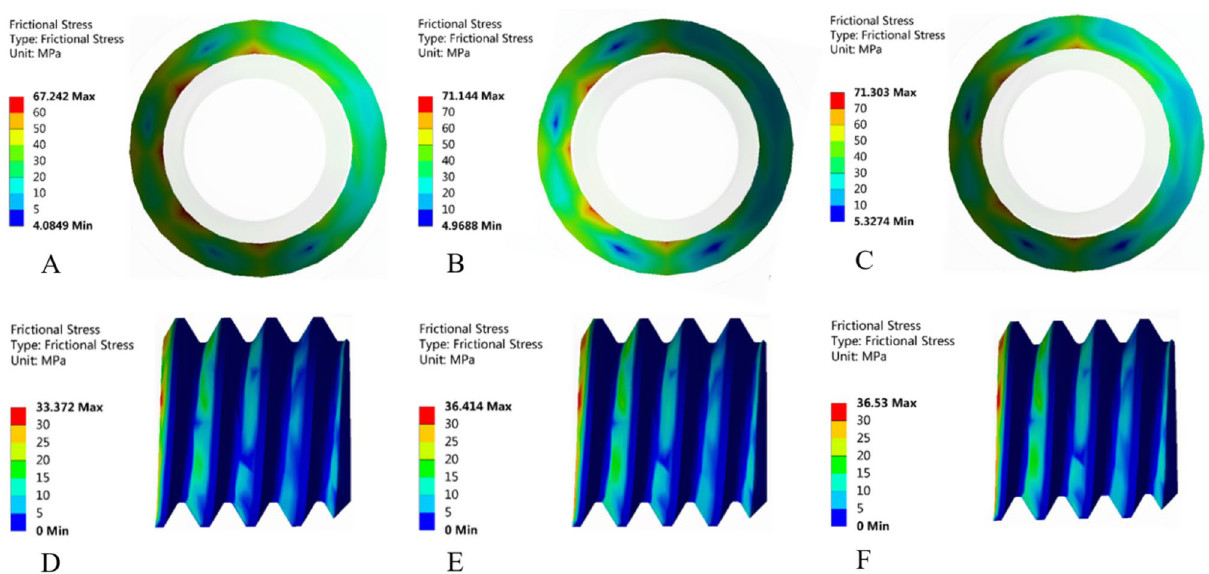
Figure 10. Frictional stress distribution of the screw taper surface and thread surface. ( A , D ) NC group, ( B , E ) SC group, and ( C , F ) MC